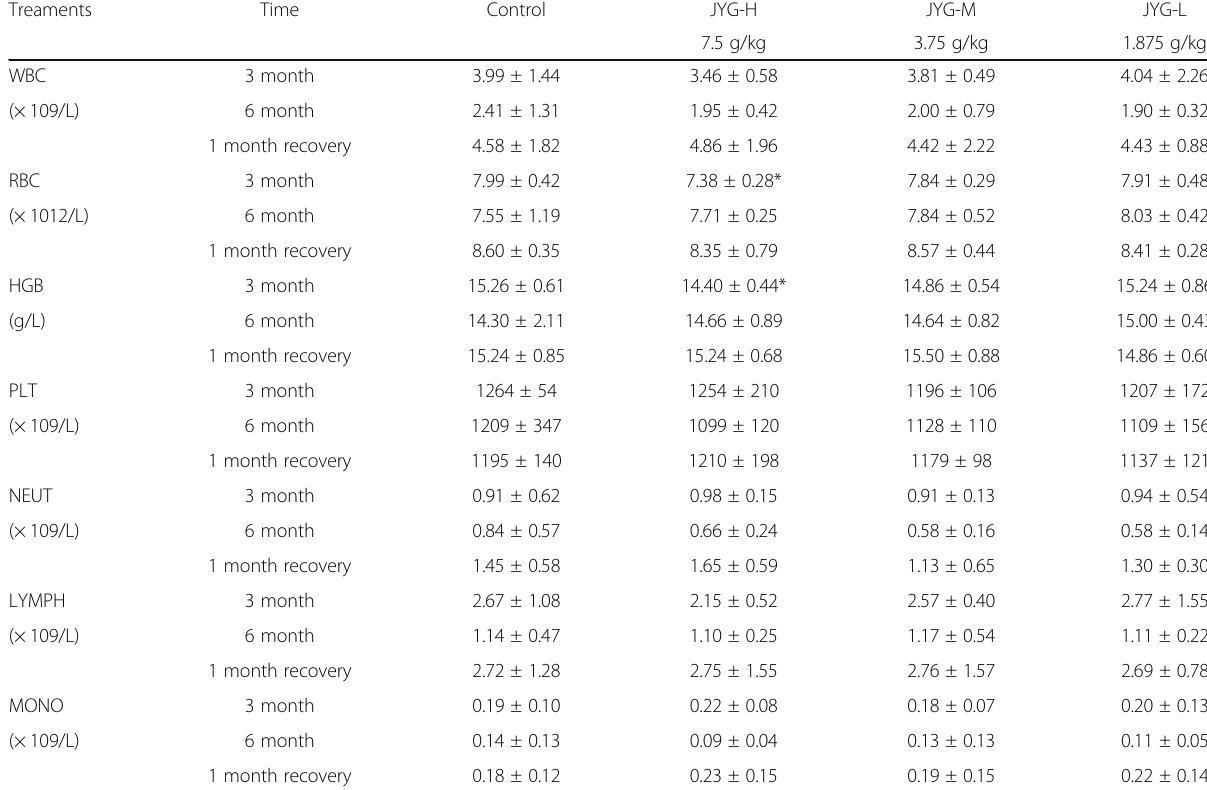
Table 3 Hematological parameters of female rats in chronic toxicity test Treaments